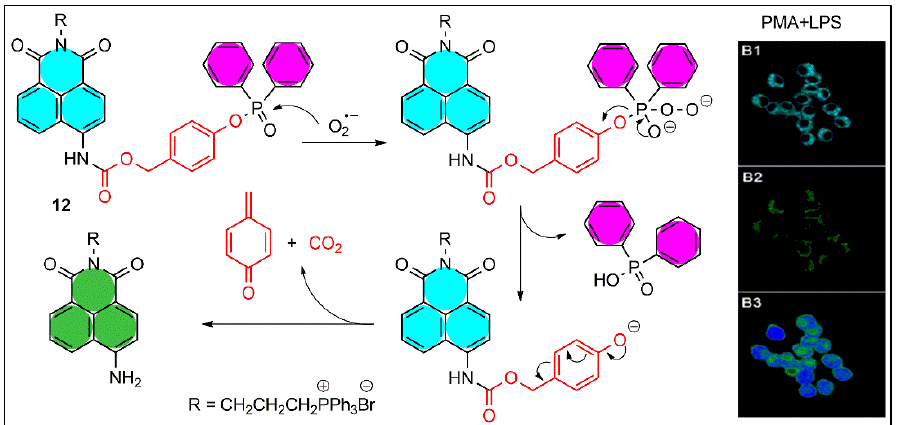
Figure 12. Proposed sensing mechanism of 12 toward O 2 •− . Fluorescence imaging with endogenous O 2 •− using probe 12 (2 μM) for 30 min. RAW264.7 cells were treated with PMA/LPS and stained with 12 . Adapted with permission from [71]. Copyright (2018) American Chemical Society.